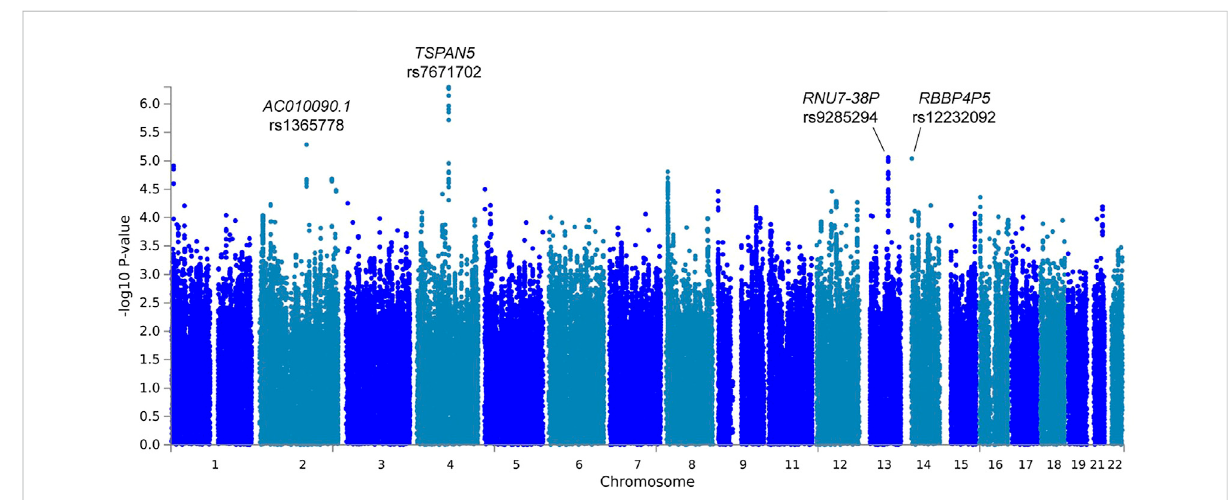
ManhattanplotoftheprimaryGWASmeta-analysis,includingpatientstreatedwithcisplatinorcarboplatinandpatientswithandwithoutcranial irradiation. In this analysis, patients with SIOP grade 0 are considered controls and patients with SIOP grade ≥ 1 are